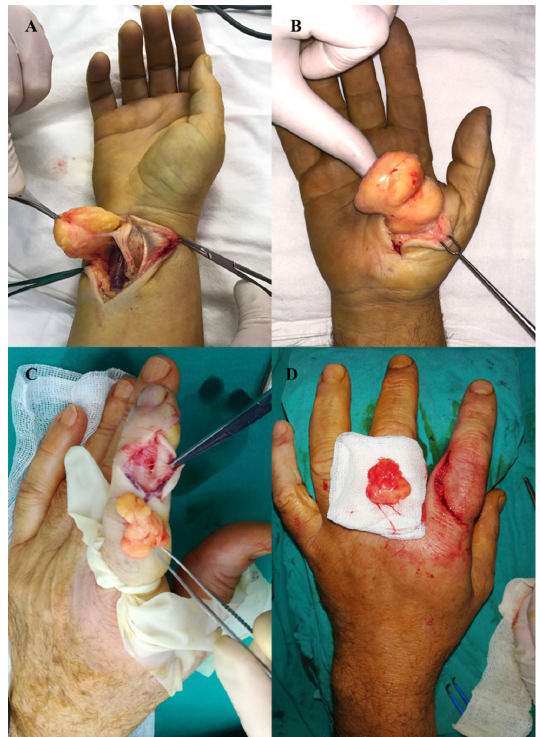
Figure 5. Intraoperative aspects of lipoma excision: ( A ) wrist, ( B ) thenar eminence, and ( C ) dorsal face of the index finger with removed specimen ( D ).